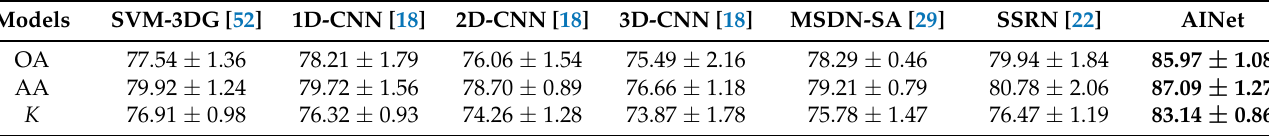
Table 10. Classification results with spatially disjoint samples for the Indian Pines dataset.